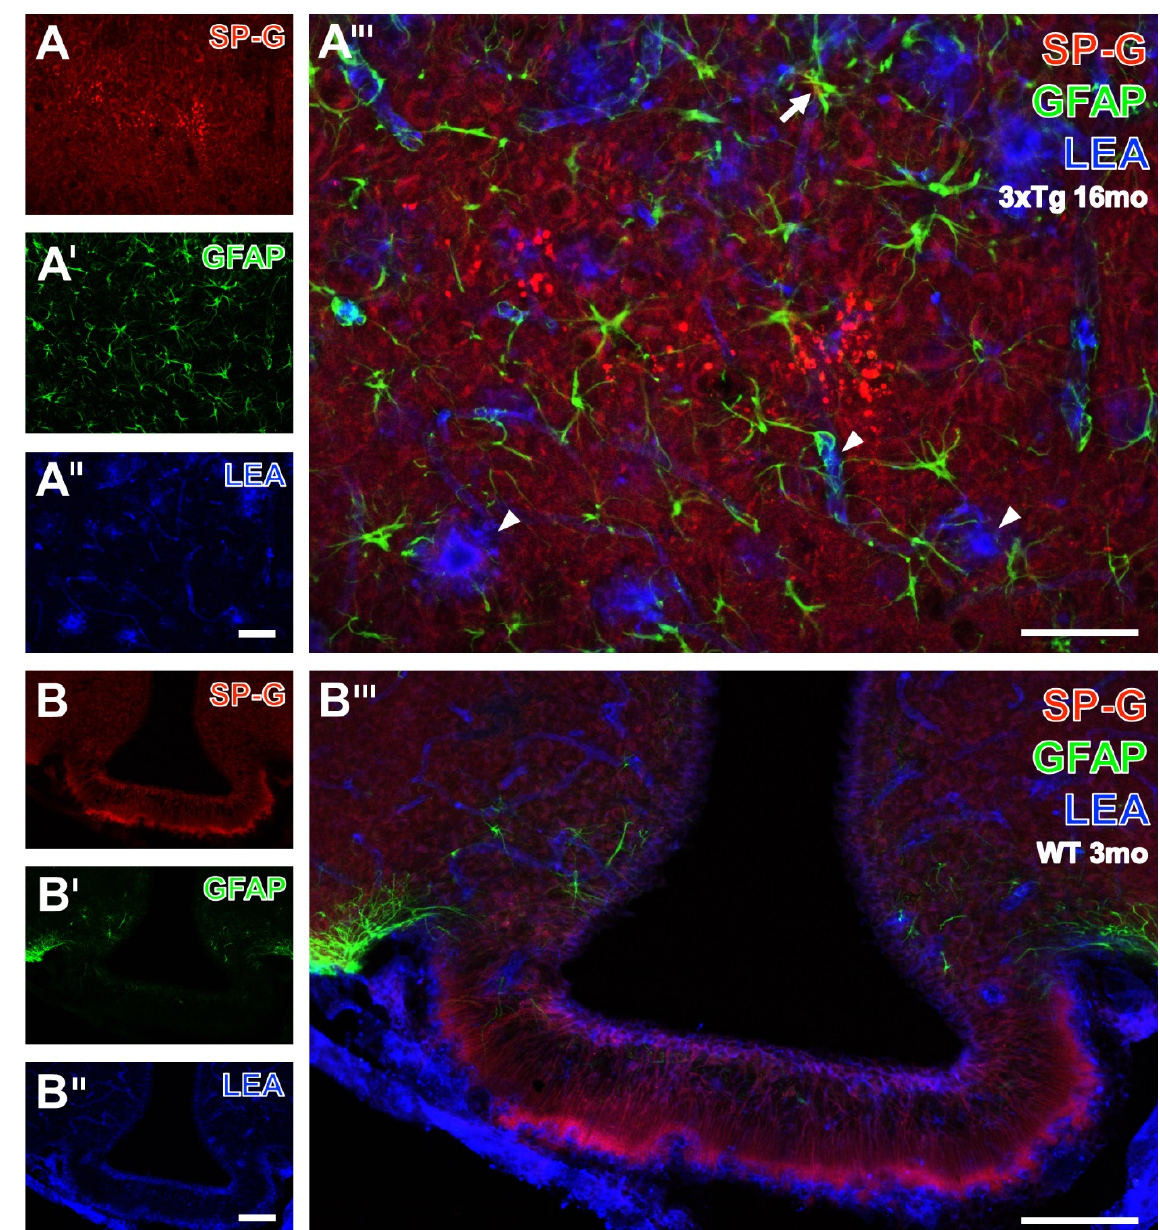
Figure 7. Visualization of SP-G-ir and LEA-binding sites in combination with the immunodetection of astroglial GFAP. As shown at higher magnification ( A – A’’’ ), the hippocampal CA1 region from a 16 month-old 3xTg mouse displays a faint SP-G-ir of the neuropil and numerous strongly labeled, partially clustered dots ( A ). Counterstaining reveals astrocytes with frequently elaborated processes ( A’ ) and LEA-binding of vessels and plaque-like structures ( A’’ ). The higher-magnified overlay con- firms the occurrence of LEA-positive plaques (arrowheads), surrounded by apparently activated astroglia, as exemplified by an arrow. Additionally, several astrocytic processes targeting the vas- culature are visible but distant from the SP-G-containing dots. The same triple staining of the infun- dibulum from a 3 month-old WT mouse ( B – B’’’ ) elucidates in ( B ) that numerous SP-G-immunore- active fibers arise in zone I and stretch through zones II to IV up to the adjacent capillaries. Con- comitant GFAP immunolabeling ( B’ ) shows moderately stained astrocytes only in the adjacent ar- cuate hypothalamic nucleus, containing several vessels visualized by LEA ( B’’ ), which also stains